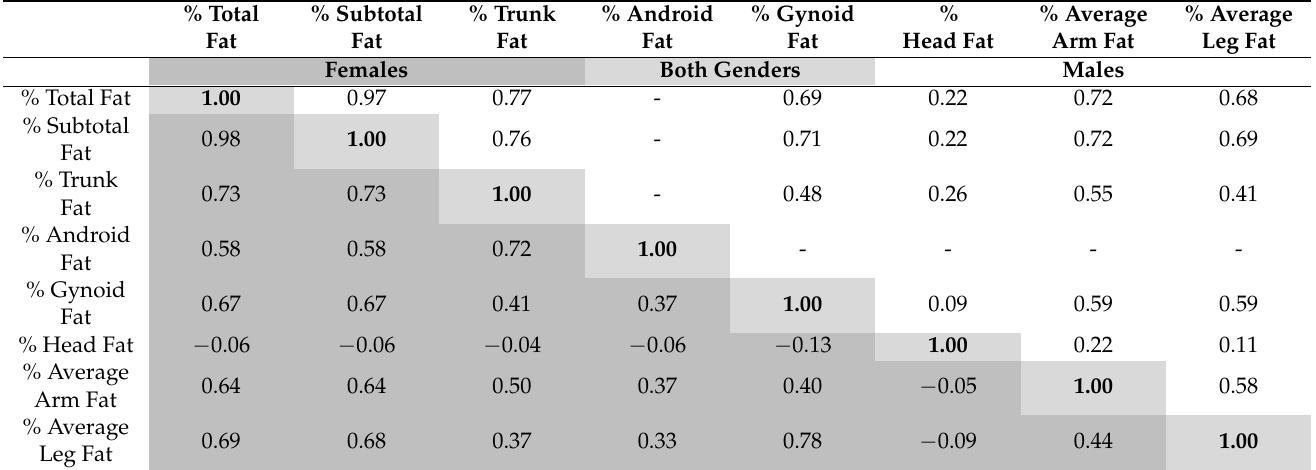
Thereafter, a marginal model was constructed to examine the influence of fat distri- bution by quartiles and the predicted probability of NAFLD, segregated by gender in the non-obese (Table 3) population. In non-obese individuals, males were shown to have a higher probability of NAFLD than females in each quartile of body fat percentage. Fur- thermore, the association between increasing fat mass and NAFLD risk was considerably more prominent in males than females. Percent leg fat was associated with one of the lowest marginal probabilities (22.25%, 95%CI: 15.75–28.74) of NAFLD in Q4 of percent body fat. Of all regional body fat measures in males, Q4 of truncal fat was associated with the highest predictive probability of NAFLD (56.57%, 95%CI: 53.37–59.75), four times the corresponding probability of NAFLD associated with trunk fat in females (13.21%, 95%CI: 10.11–16.30). Interestingly, Q4 of head fat demonstrated the highest predictive probability of NAFLD in females (13.81%, 95%CI: 10.82–16.79), while simultaneously having the lowest associated marginal probability in males (21.89%, 95%CI: